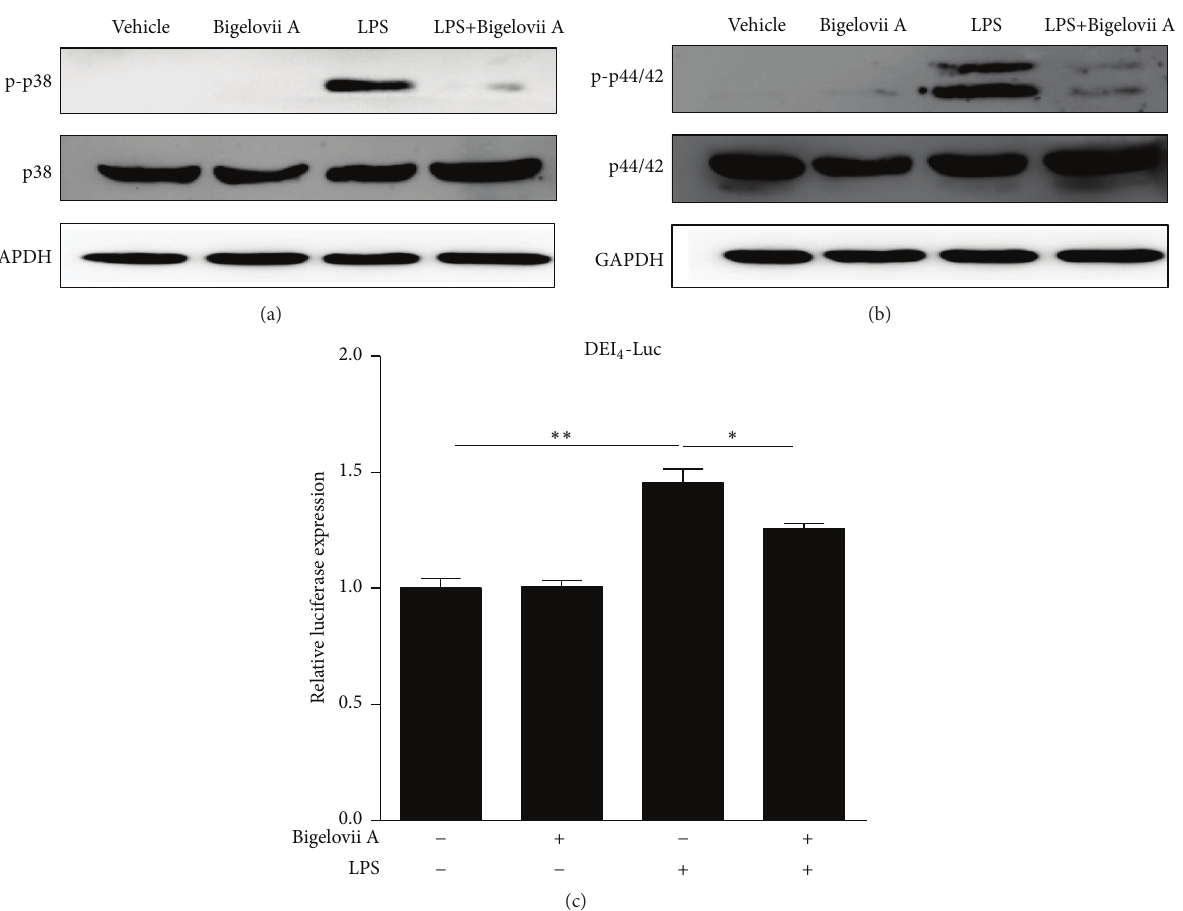
Figure 9: Effect of Bigelovii A on p38 MAPK/ERK1/2—C/EBP 𝛿 signaling pathway during LPS-induced inflammation in MH-S cells. (a) and (b)MH-Scellswerepretreatedwithorwithout10 𝜇 MofBigeloviiAfor1h,followedbytreatmentwithPBSor100ng/mLofLPSfor15min,and total proteins were isolated. Western blot was performed by using antibodies against p-p38, p38, p-p44/42, p44/42, and GAPDH, respectively. (c) MH-S cells were transiently transfected with total of 0.5 𝜇 g indicated plasmids. 48h after transfection, the cells were pretreated with or without 10 𝜇 M of Bigelovii A for 1h, followed by treatment with PBS or 100 ng/mL of LPS. 4 h later, the cells were lysed, and luciferase activity was measured. Luminometer values were normalized for expression from a cotransfected pRL-TK gene and negative control sequentially. Results are reflected by means ± SEM ( 𝑛 = 3 ). ∗ and ∗∗ indicated statistically significant difference, 𝑝 < 0.05 and 0.01, respectively. Negative control: cells treated by Vehicle plus PBS. Positive control: cells receiving LPS plus Vehicle